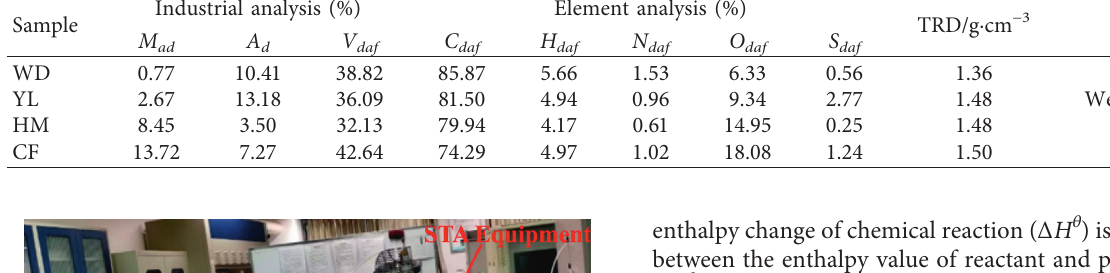
Table 1: Industrial analysis and element analysis of the coal samples. Sample